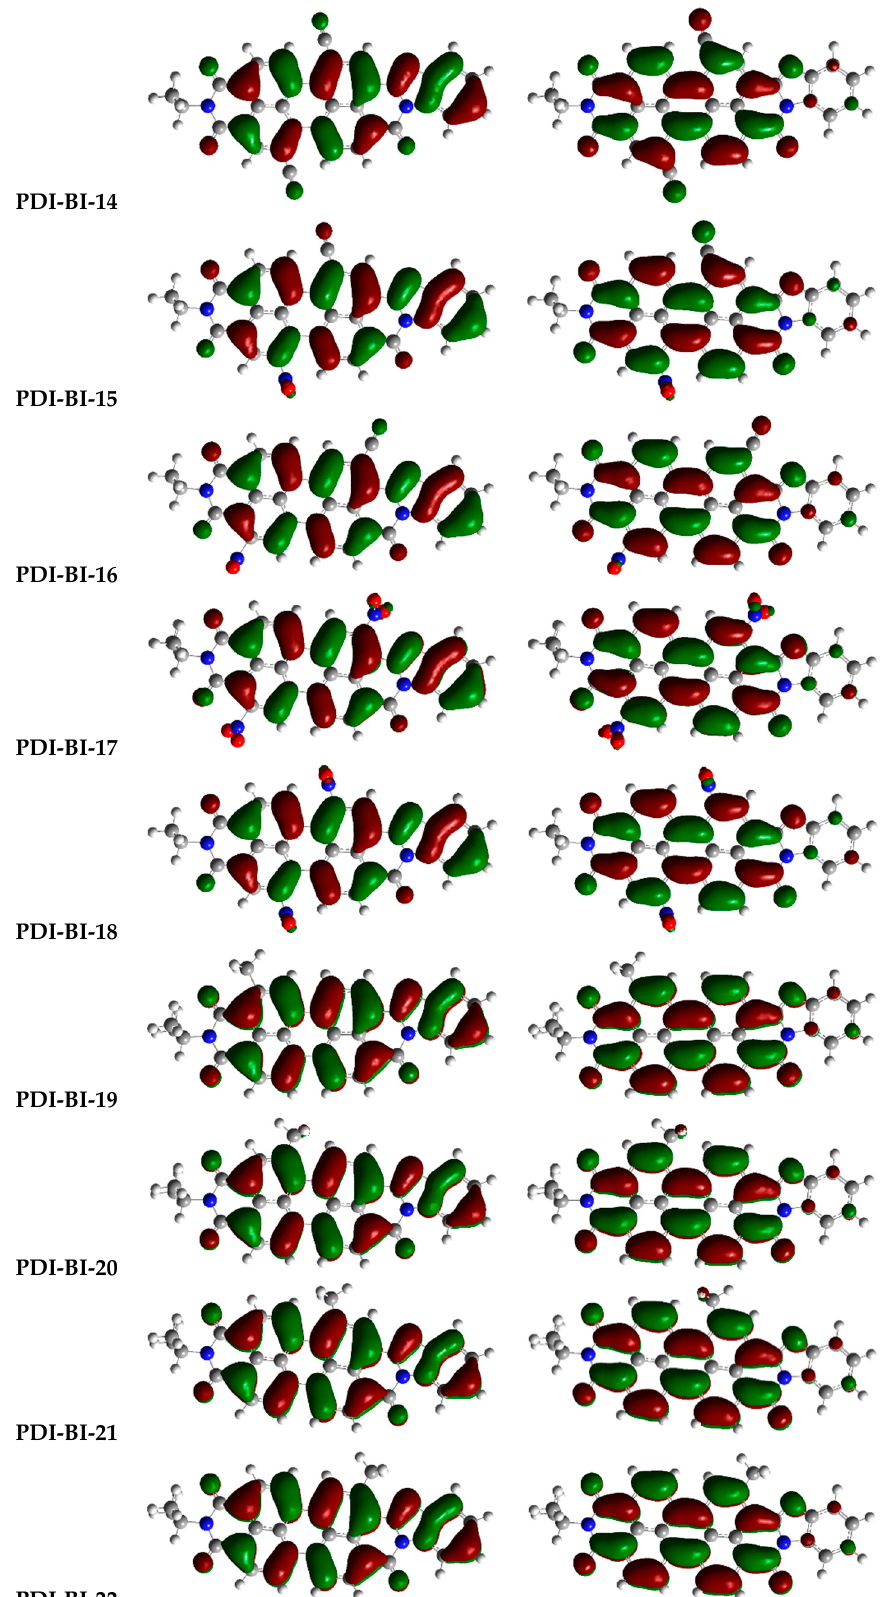
Figure 2. Cont. Figure 2.